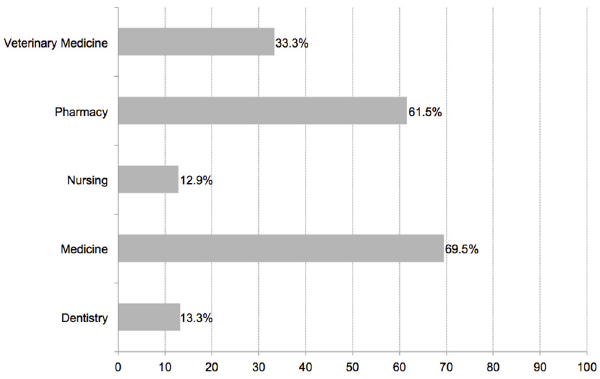
Fig 1. Faculties teaching all recommended AS principles, by